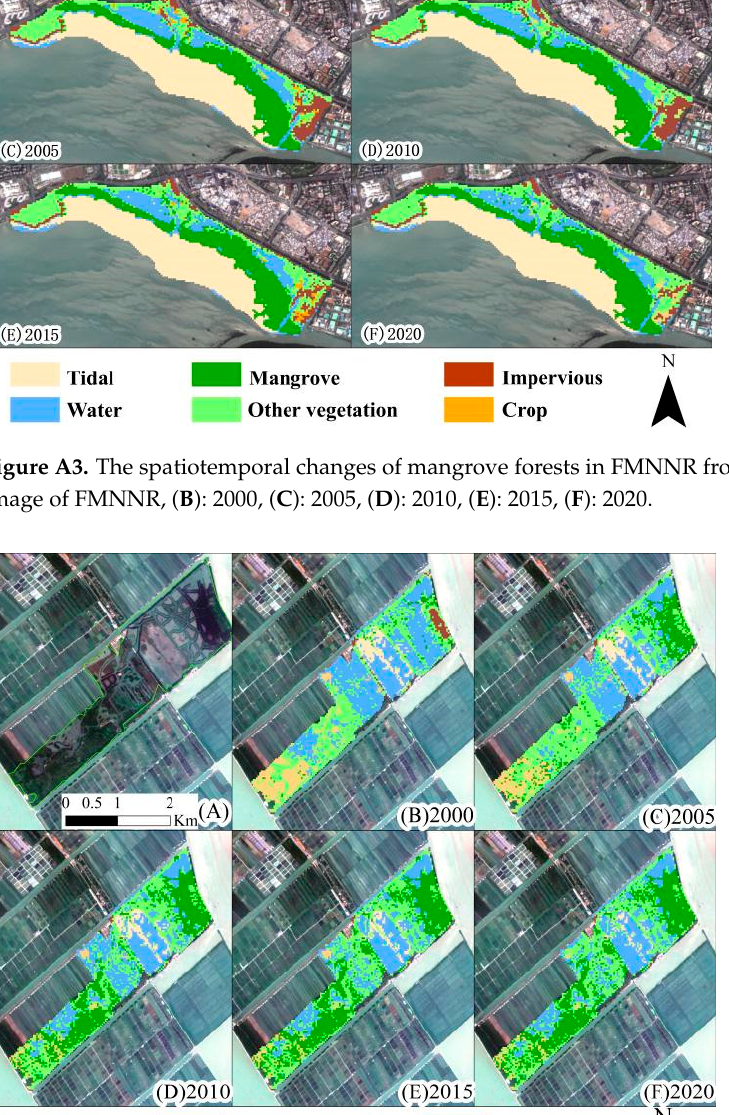
Figure A4. The spatiotemporal changes of mangrove forests in NWP from 2000 to 2020. ( A ): the image of NWP, ( B ): 2000, ( C ): 2005, ( D ): 2010, ( E ): 2015, ( F ): 2020.